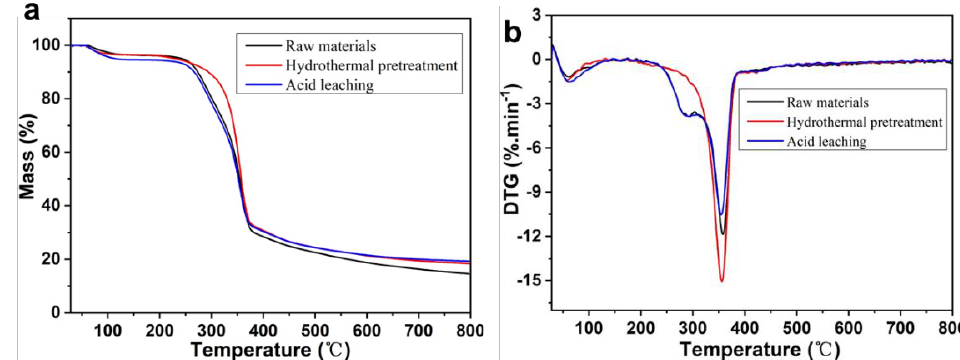
Figure 3. TG ( a ) and DTG ( b ) of eucalyptus with or without acid leaching and hydrothermal pre-treatment.